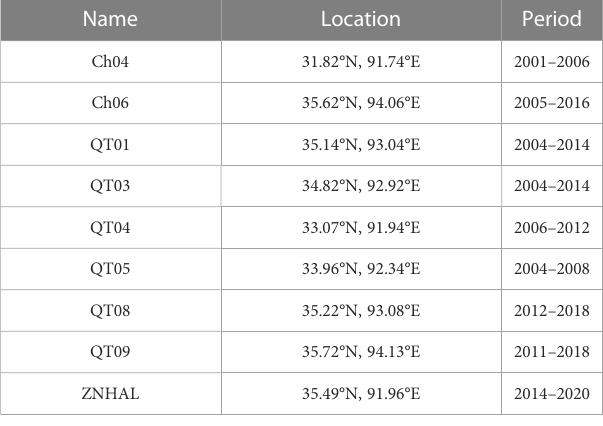
TABLE 1 List of sample sites of soil moisture observations used in this